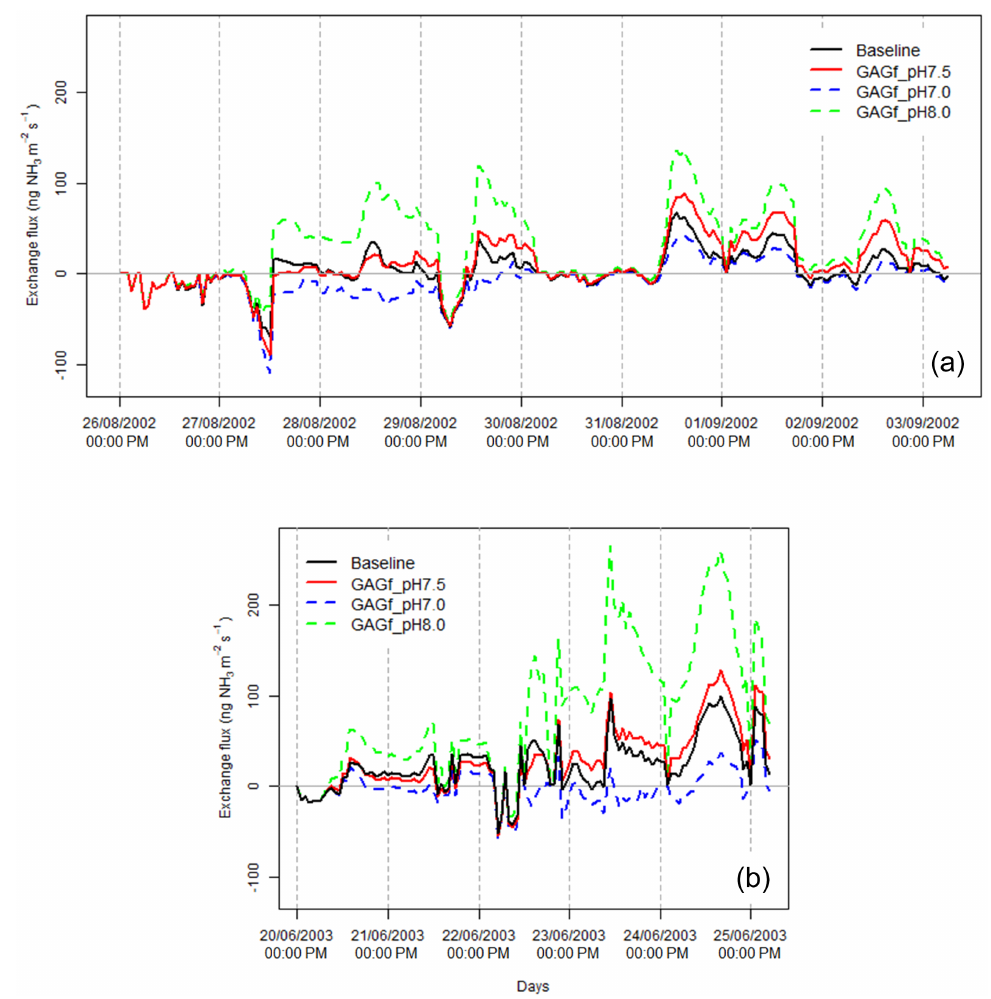
Figure 16. NH 3 exchange fluxes simulated by GAG_field with the original dynamic approach for soil pH (Baseline), and when constant values of soil pH were assumed: pH 7.5 (GAGf_pH7.5), pH 7.0 (GAGf_pH7.0) and pH 8.0 (GAGf_pH8.0). Simulations were carried out for both modelling periods, P2002 (a) and P2003 (b)